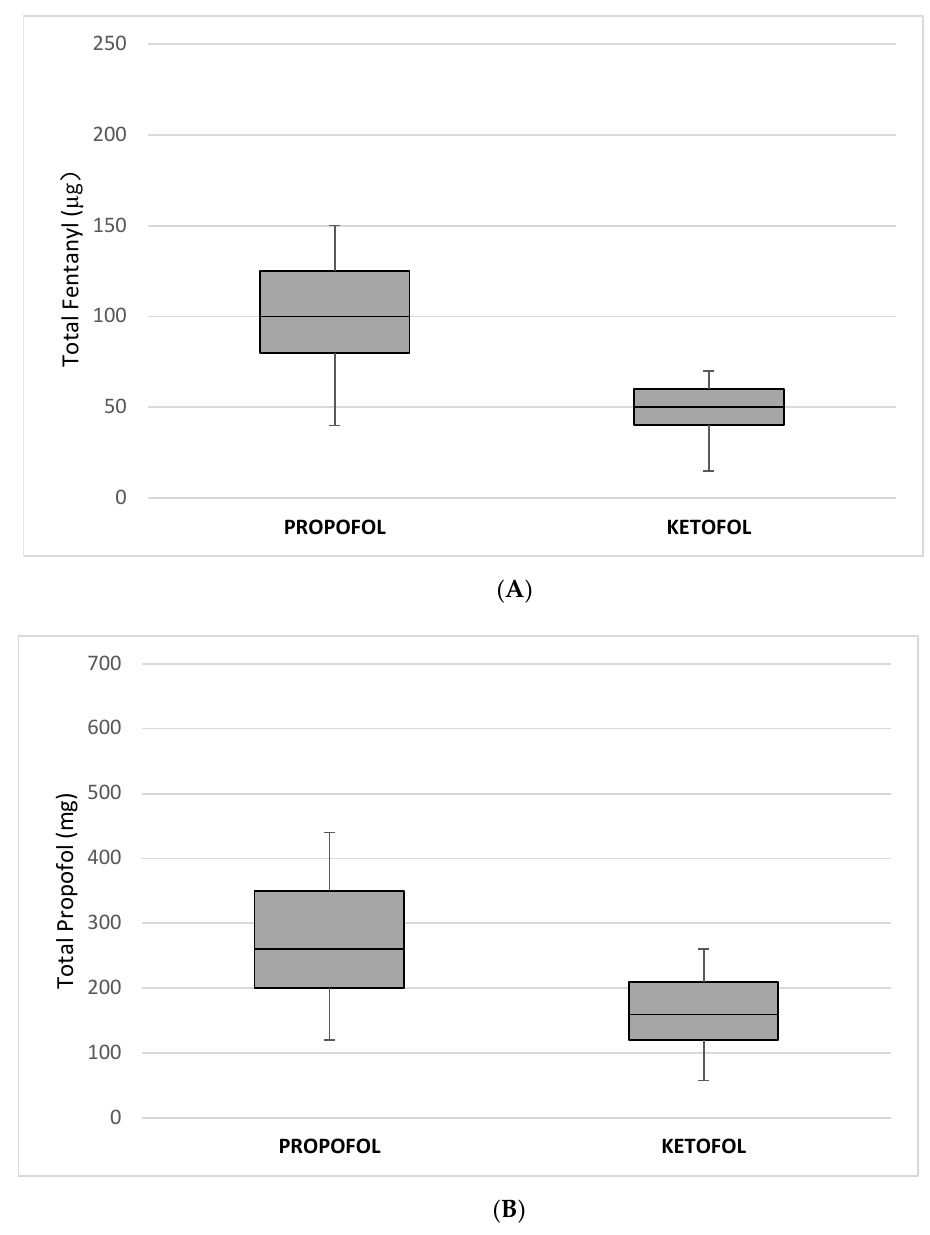
Figure 2. Comparison of ( A ) total fentanyl and ( B ) propofol consumption between the propofol and the ketofol groups.